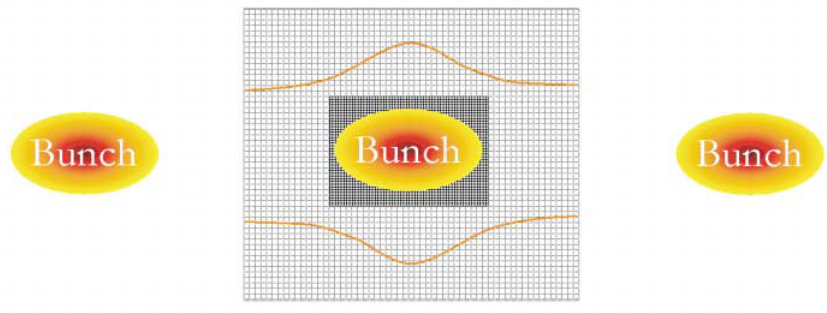
FIG. 3. (Color) Scheme of the adaptive mesh refinement.